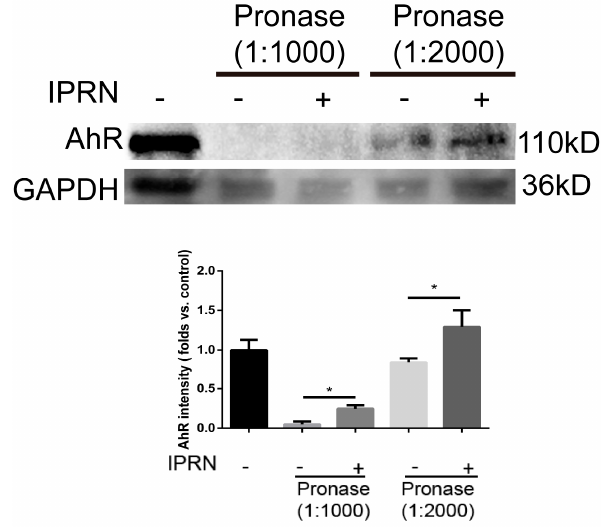
Figure 4. IPRN directly binds to AhR. For the DARTS assay, MC3T3-E1 cell lysates (5 mg/mL) were incubated with IPRN (10 µ M) or an equal volume of DMSO for 1 h at room temperature, followed by digestion with pronase to protein ratios of 1:1000 or 1:2000 for 30 min. The samples were analyzed using Western blotting. Data are presented as the mean ± SD ( n = 3). * p < 0.05.